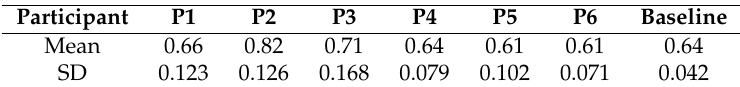
Table 2. Comparison of the HSE with the MSE. Mean and standard deviation (SD) of the expert-verified resistance measurements ( Ω ) over: (i) all the HSE produced by the participants (as indicated); and (ii) the baseline MSE.